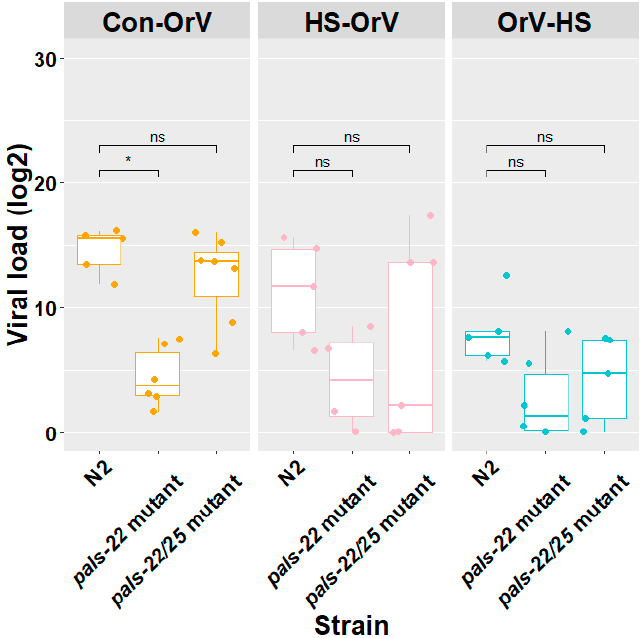
Figure 4. Viral load of N2, the pals-22 and the pals-22 pals-25 mutants under combined HS and viral stress. Con-OrV: control with only OrV infection; HS-OrV: HS before Orsay virus infection; OrV-HS: HS 2 h after Orsay virus infection. Dots: infected biological replicates (each dot is a biological replicate). Differences with N2 were tested, Tukey HSD test. *: significantly different, p < 0.05.